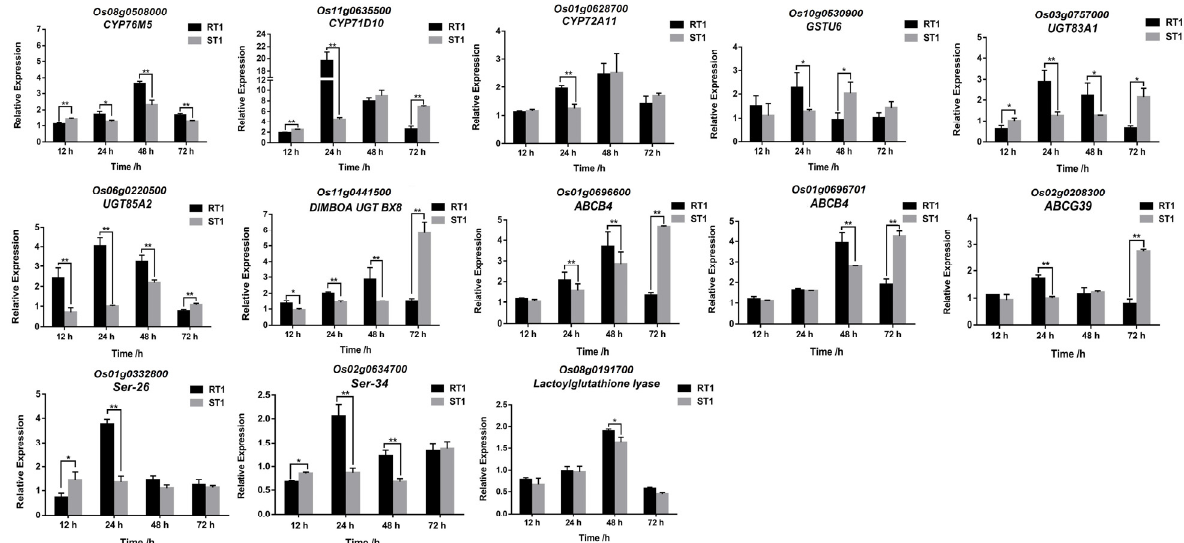
Figure 5. Expression patterns of key genes after FE treatment in 9311 and MXZ. The RT1 control was RCK, and the ST1 control was SCK. The gene expression levels were measured by using the 2 − ∆∆ Ct method. Values represent the averages of three replicated, and the error bars represent standard errors. Asterisks indicate statistically significant differences between the two treatments according to Duncan’s test (*: p ≤ 0.05; **: p ≤ 0.01).